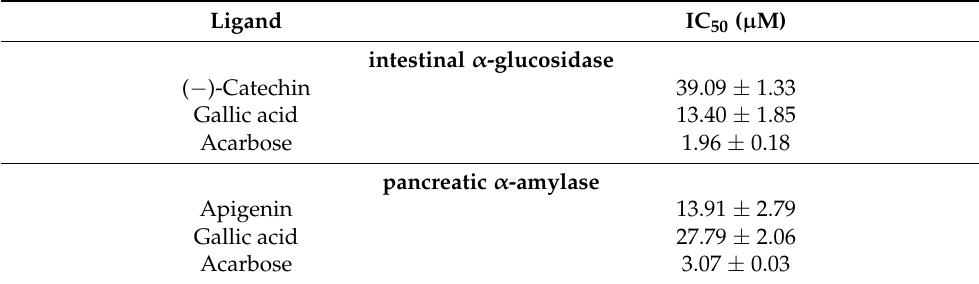
Figure 7. IC 50 curves (with x = inhibitor concentration in µM; y = inhibition percentage) for inhibition of intestinal α -glucosidase by (-)-catechin, gallic acid, and acarbose alone or in the presence of (-)-catechin (10 µM), and pancreatic α -amylase by apigenin, gallic acid, and acarbose alone or in the presence of apigenin (10 µM). Table 2. IC 50 values for intestinal α -glucosidase and pancreatic α -amylase